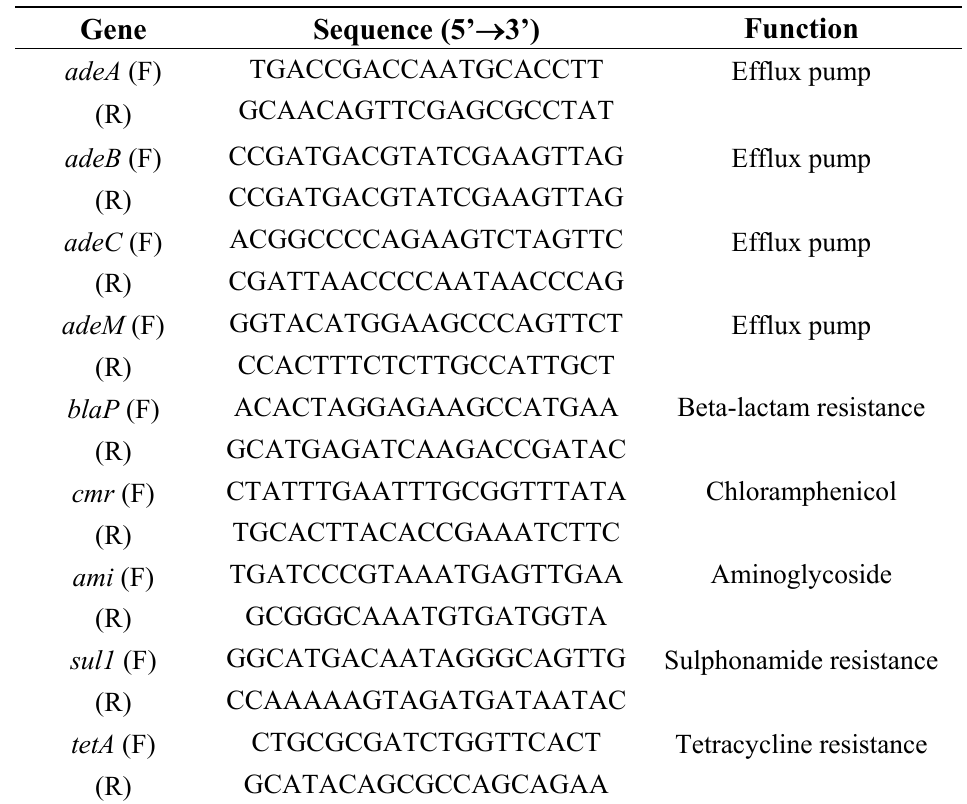
Table 1. Primers used in the